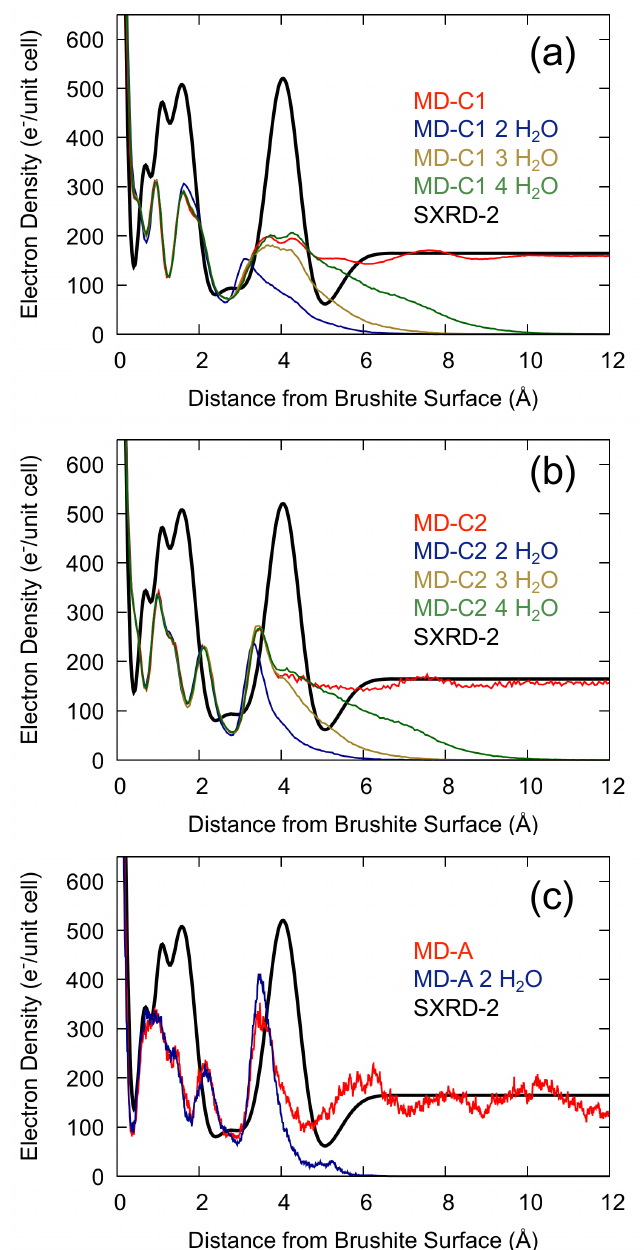
Figure 3. The interfacial water structure with 2, 3, and 4 layers of water using ( a ) the Demichelis et al. force field (MD-C1) [24], ( b ) the modified Demichelis et al. force field (MD-C2) and ( c ) ab initio methods (MD-A) (for this last case only the two-layer coverage was